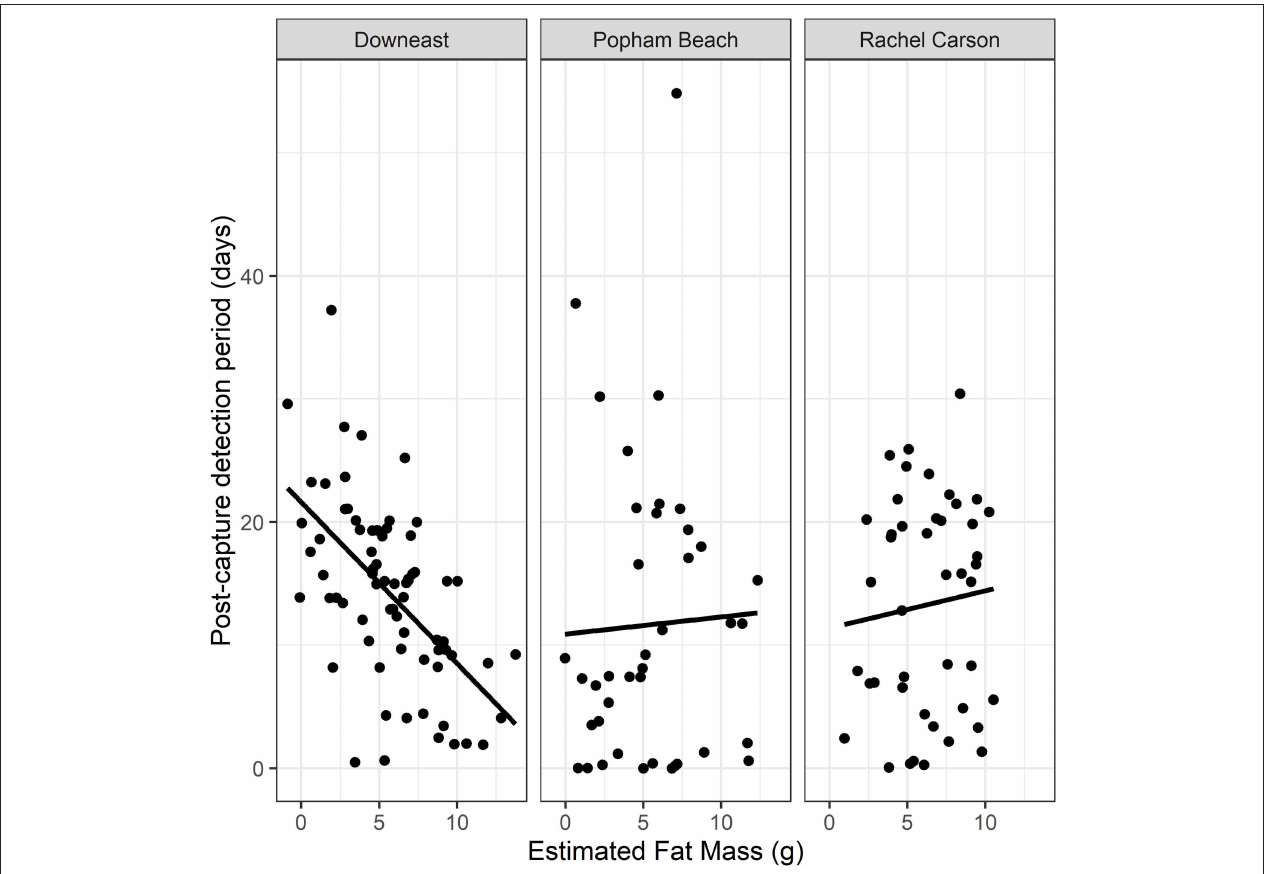
FIGURE 3 | Relationship between energetic condition (size-corrected Estimated Fat Mass, EFM) at the time of capture and the number of days individuals remain detected in the local area after being captured and tagged (Post-Capture Detection Period, PCDP) at each of the three tagging locations (years and ages pooled). Only the group of birds captured at the Downeast site showed a significant effect of EFM on PCDP (Downeast 2013–14: R 2 = 0.2664, P < 0.0001, df = 63; Popham Beach 2015–16: R 2 = 0.0407, P = 0.1325, df = 56; Rachel Carson NWR 2014–15: R 2 = 0.0114, P = 0.4899, df =